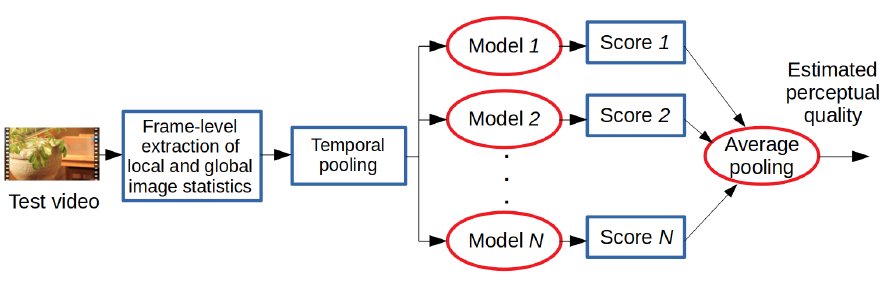
Figure 2. Testing of the proposed method. Video-level feature vectors are extracted from a test video through the temporal pooling of local and global image statistics. The scores of the trained regressors are fused together via average pooling to get an estimation of the perceptual